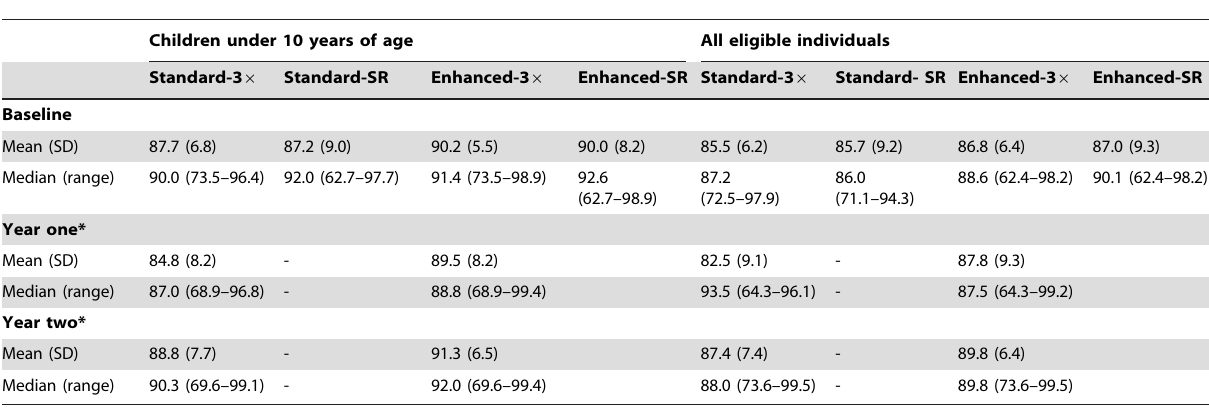
Table 2. Treatment coverage by randomisation